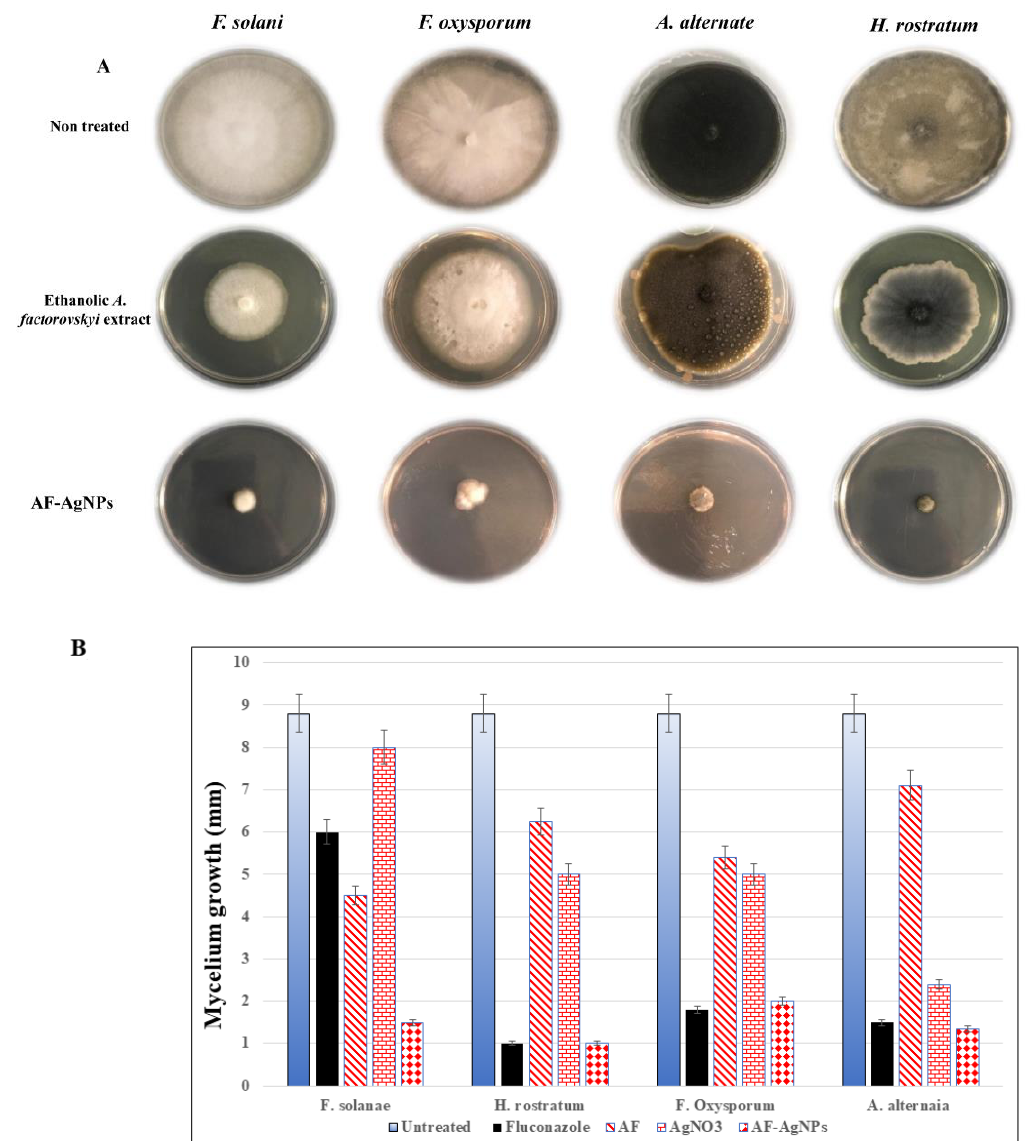
Figure 5. The antifungal activity of A. factorovskyi ethanolic extract and silver nanoparticles. The antifungal activities of A. factorovskyi , and AF-AgNPs, were tested against four fungal species. ( A ) The species were cultured on potato dextrose agar Petri dishes and treated with either A. factorovskyi ethanolic extract or AF-AgNPs. ( B ) The mycelium growth inhibition in (mm) for the fungal species treated with either A. factorovskyi ethanolic extract or the biosynthesized silver nanoparti- cles.